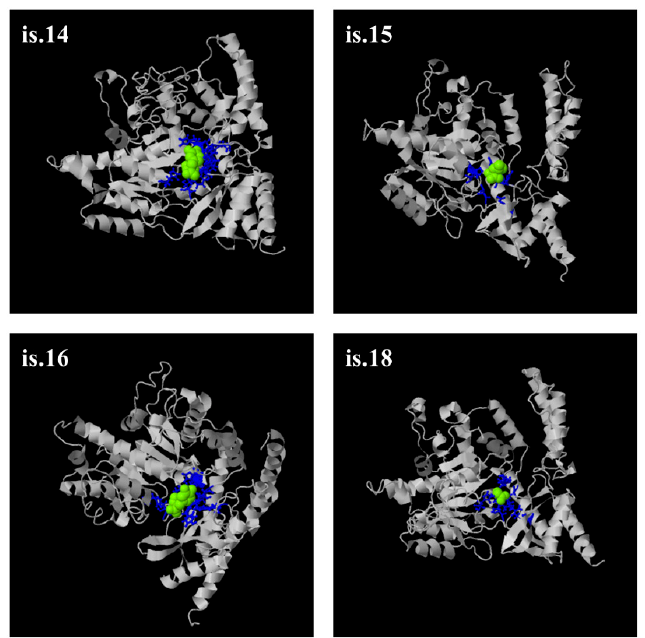
Figure 3. Predicted ligands bound to 4 of the deduced DDC isoforms (is.14, is.15, is.16, and is.18), illustrated with the use of the I-TASSER, COFACTOR (https: // zhanglab.ccmb.med.umich.edu / COFACTOR / ), and COACH (https: // zhanglab.ccmb.med.umich.edu / COACH / ) servers. Each ligand is depicted with a green-yellow sphere. Binding aa residues are shown by blue balls and sticks. Besides pyridoxal-5-phosphate (PLP), is.14 and is.16 bind carbidopa, a well-known inhibitor of DDC function. Is.15 binds the amino acid leucine and is.18 binds the amino acid glycine. All these predictions have relatively high confidence